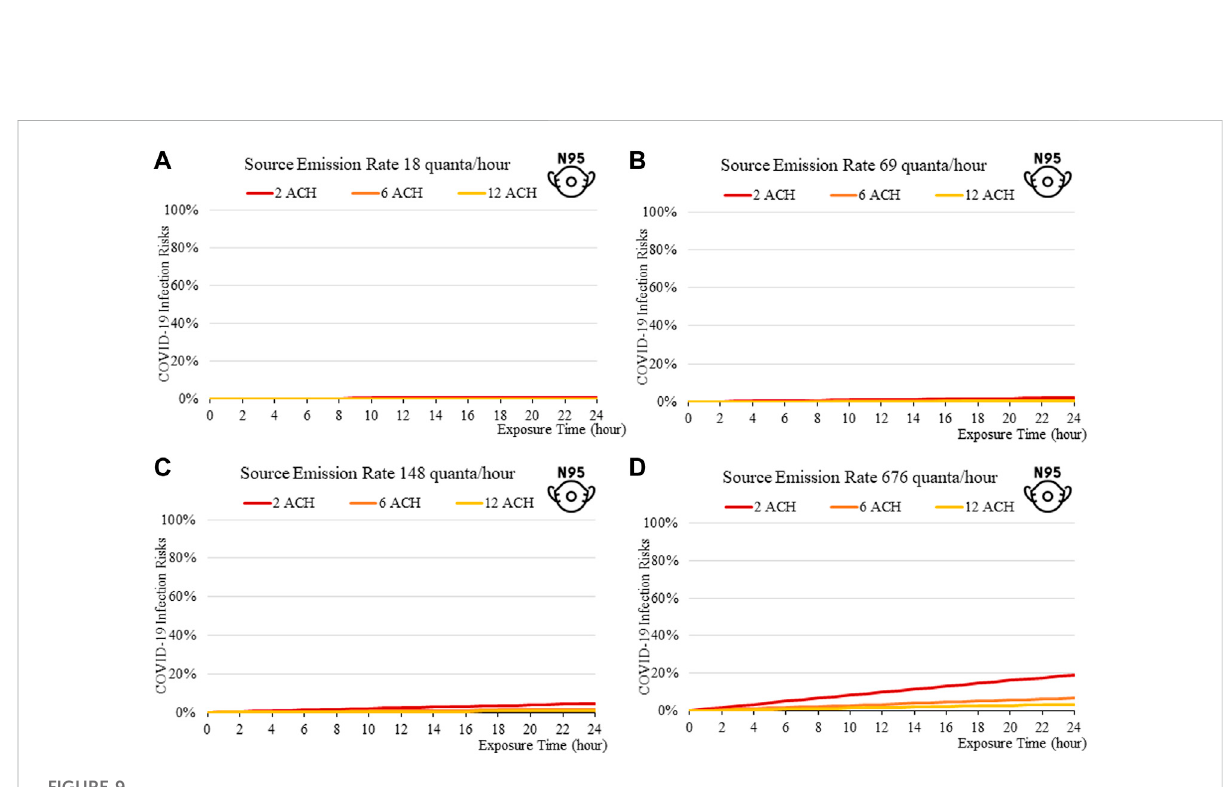
DiseaseinfectionrisksfortheDeltavariant,assumingthereceiverandtheindexpatientarebothwearingN95respiratorswiththeexhalequanta emission rate of 18 (A) , 69 (B) , 148 (C) , and 676 (D) quanta/hour for the